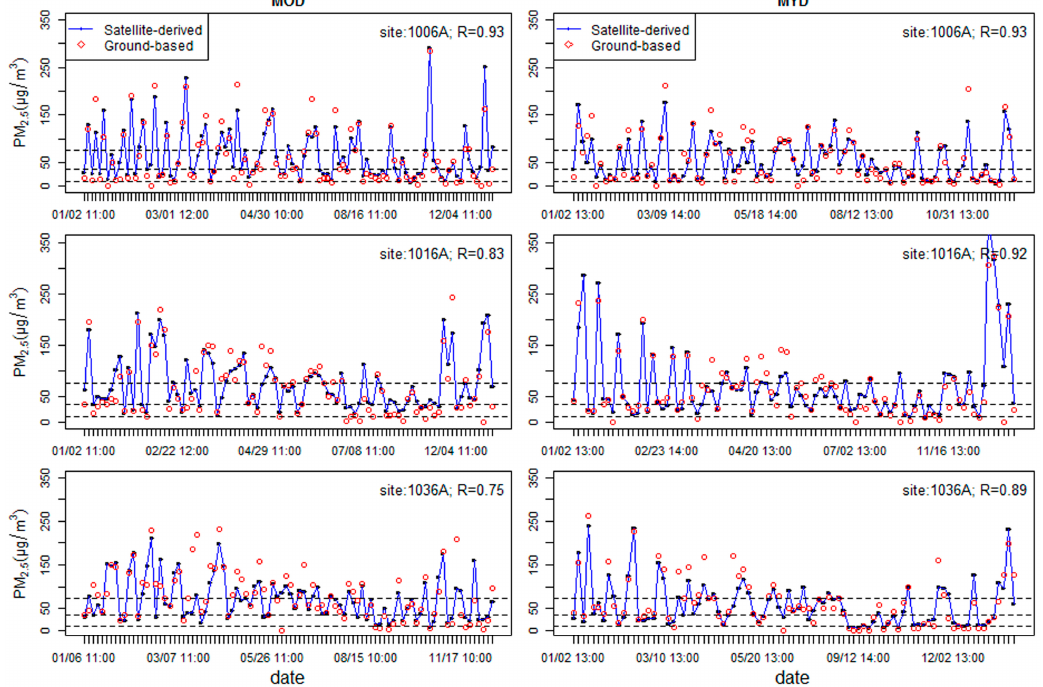
Figure 4. Examples of time-series validation for MOD- (Terra satellite; left ) and MYD (Aqua satellite; right )-derived PM 2.5 concentrations for in-site observations and RF-model-based estimations for three stations in the Beijing–Tianjin–Hebei (BTH) region using all available days. The three horizontal dashed lines from bottom to top in each panel represent the concentration levels of 15 µ g/m 3 , 35 µ g/m 3 , and 75 µ g/m 3 , respectively.